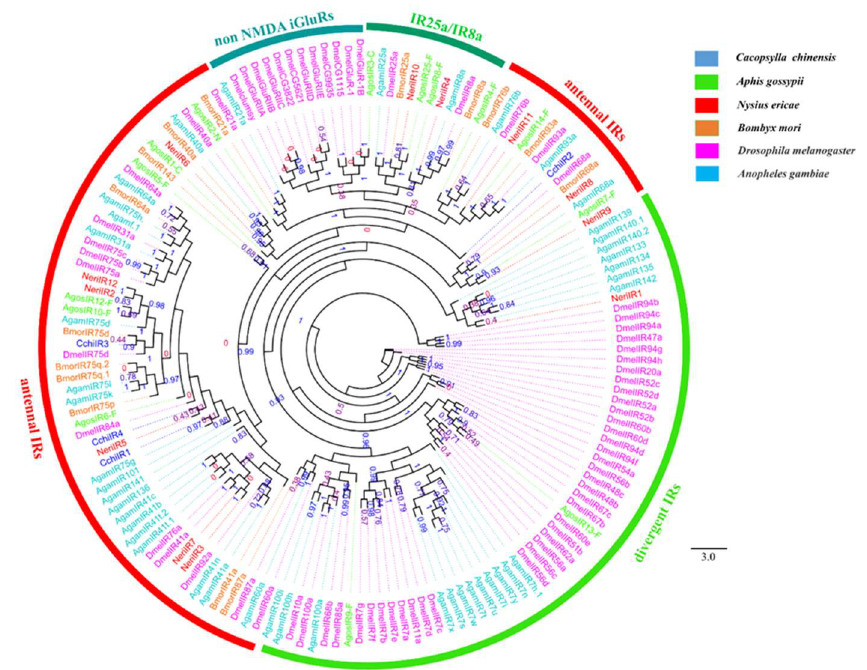
Figure 8. Phylogenetic tree of insect ionotropic receptors (IRs). The C. chinensis translated genes are shown in blue. Other insects are as follows: Aphis gossypii , Nysius ericae, Bombyx mori, Drosophila melanogaster, Anopheles gambiae . This tree was constructed using PhyML based on the alignment results of ClustalX2.0.